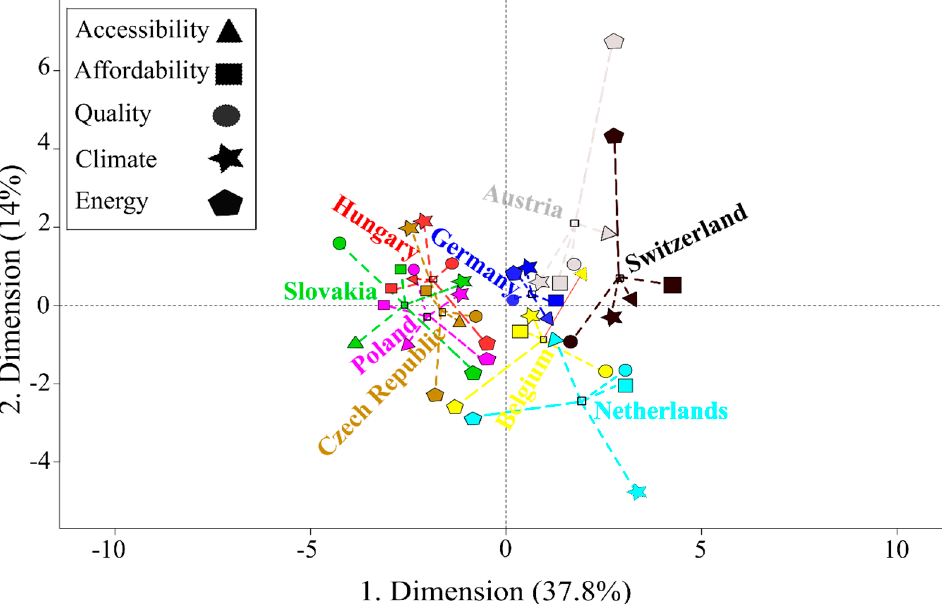
Figure 3. The contributions of each block (grand challenges) to the position of CE countries. DIM1 corresponds to 37.8%, DIM2 explains 14% of the inertia. Notes: estimations are based on MFA.